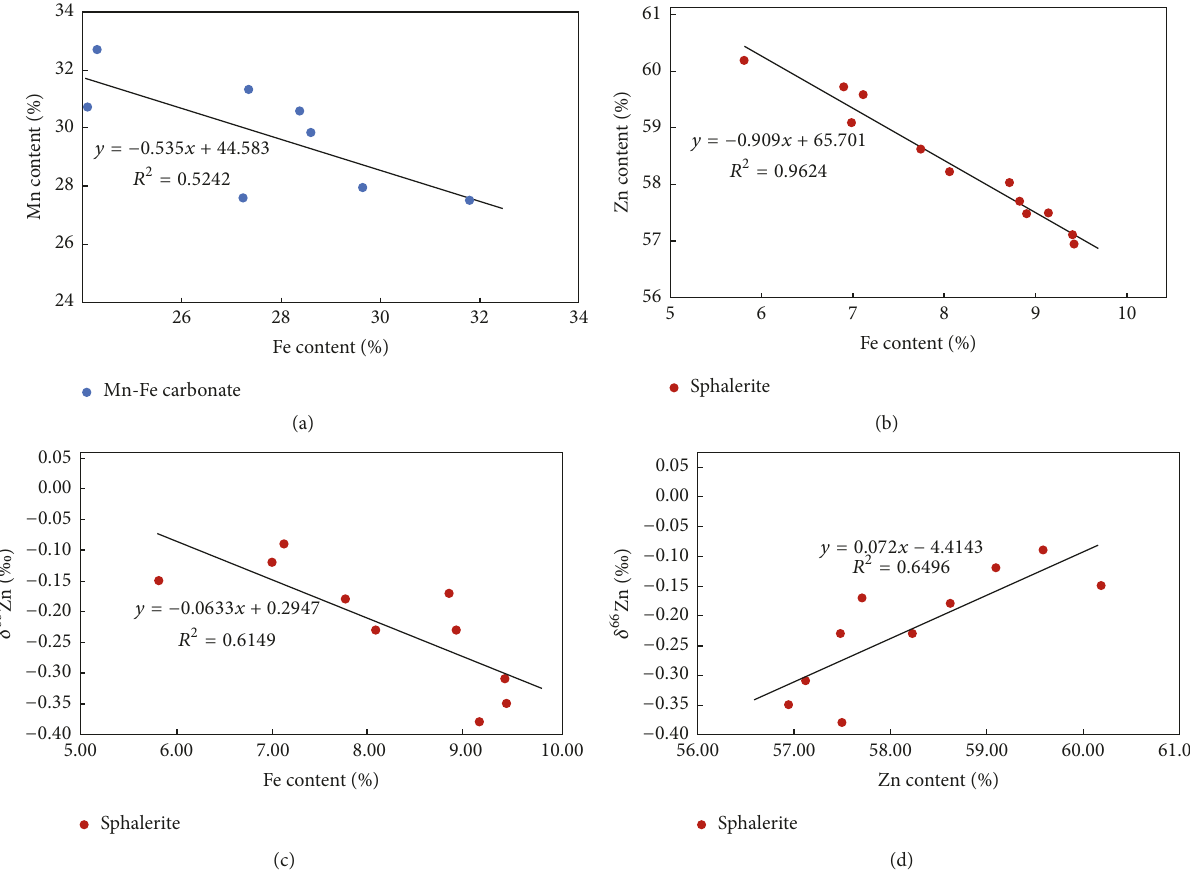
Figure 7: (a) The negative correlation between Mn and Fe contents within Mn-Fe carbonate. (b) The negative correlation between Zn and Fe contents within sphalerite. (c) The negative correlation between 𝛿 66 Zn values and Fe contents within sphalerite from 9-3, 9-8, and ZXK-1. (d) The positive correlation between 𝛿 66 Zn values and Zn contents within sphalerite from 9-3, 9-8, and ZXK-1.